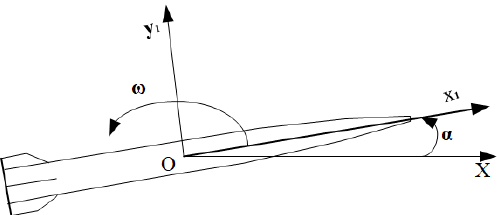
Figure 15. Schematic diagram of the swing of the ultrahigh-speed vehicle.